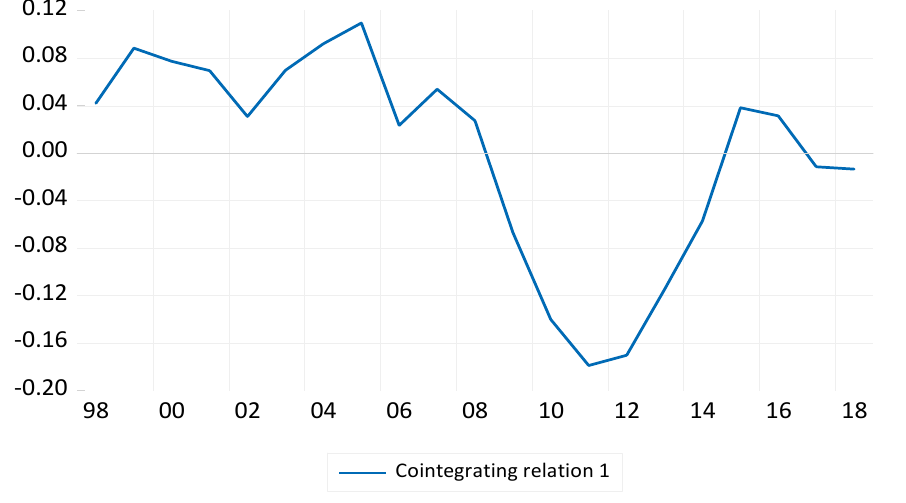
Figure 2. Cointegrating equation. Table 5. VECM Estimation